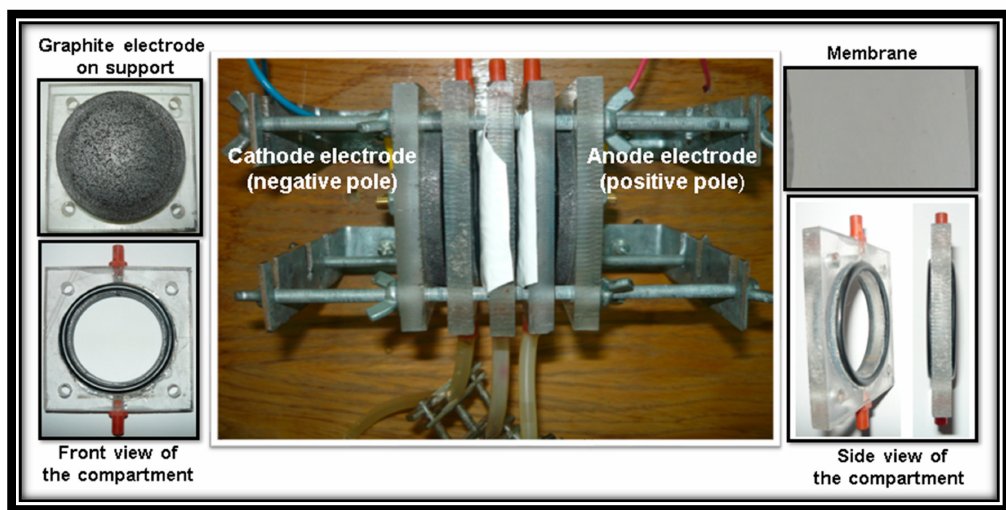
Figure 2. Laboratory electrodialysis system with polymeric